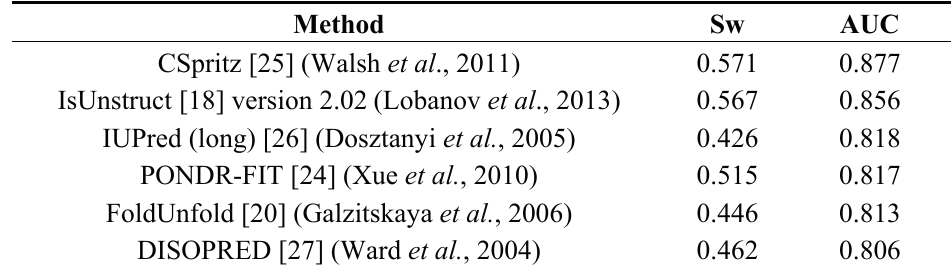
Table 3. Performance of disorder prediction methods on DisProt database version 3.7. Predictors are ranked according to